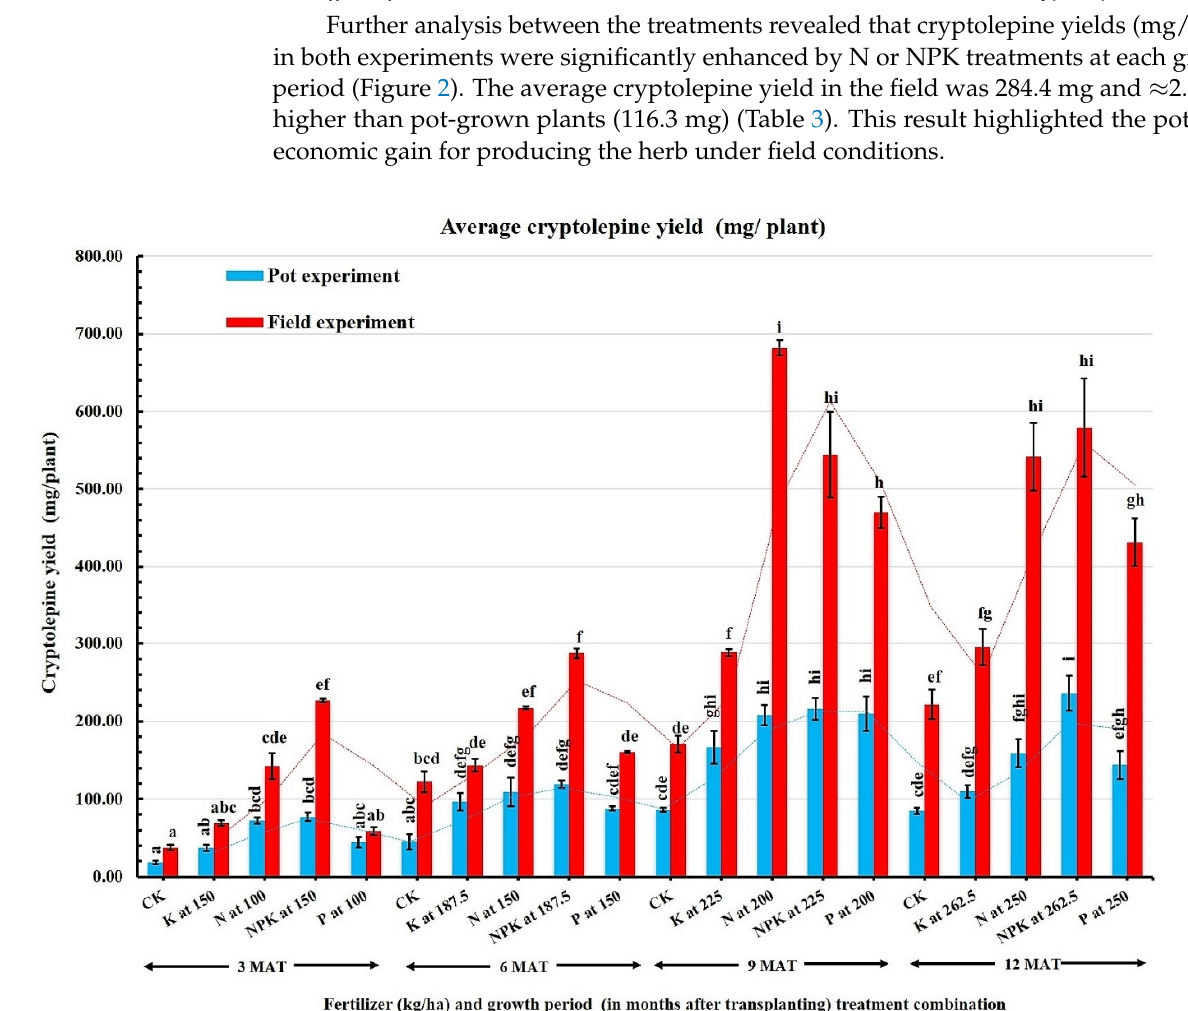
Figure 2. Cryptolepine yield in roots of C. sanguinolenta in response to fertilizer treatments within four growth periods. The growth periods/plant ages are in months after transplanting (MAT), and CK, K, N, NPK, and P denote the treatments applied: Control, Potassium, Nitrogen, combined NPK, and Phosphorus, respectively. Bars represent the mean of three replicates, and error bars are the SEM. Bars having the same color followed by different letters are significantly different at p ≤ 0.05 based on the LSD test.